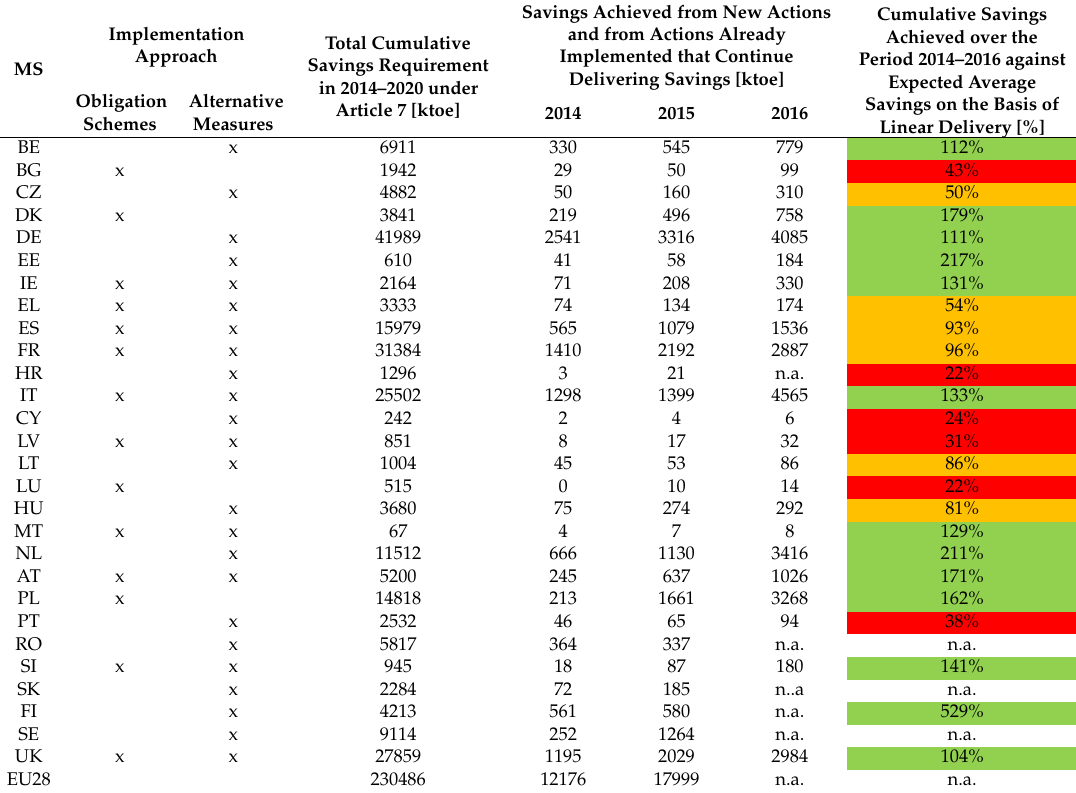
Table 7. Implementation status of Article 7 (final energy values are